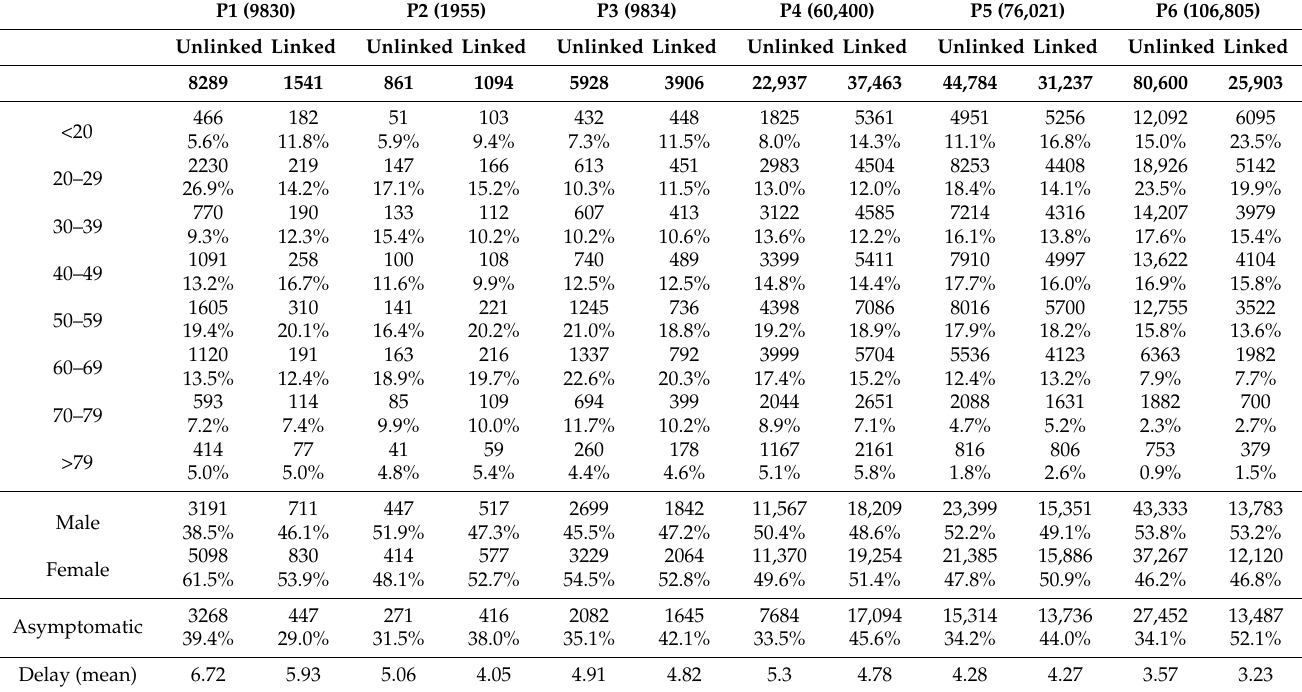
Table 5. Confirmed cases assorted according to age, gender, period, and link